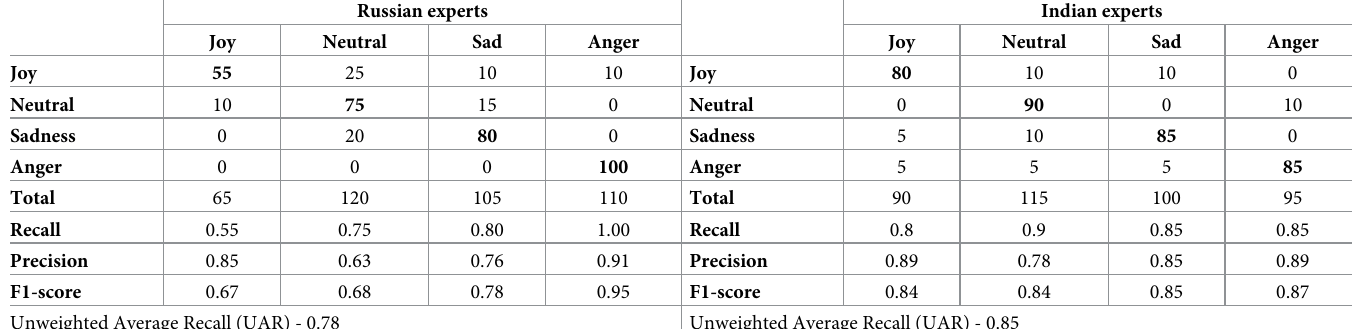
Table 7. Confusion matrix for emotion recognition in the emotional words of Tamil children by Russian and Indian experts. Russian experts